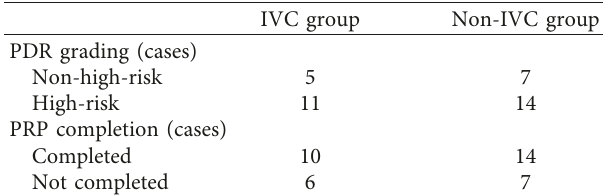
Table 3: PDR grading and PRP completion in the fellow